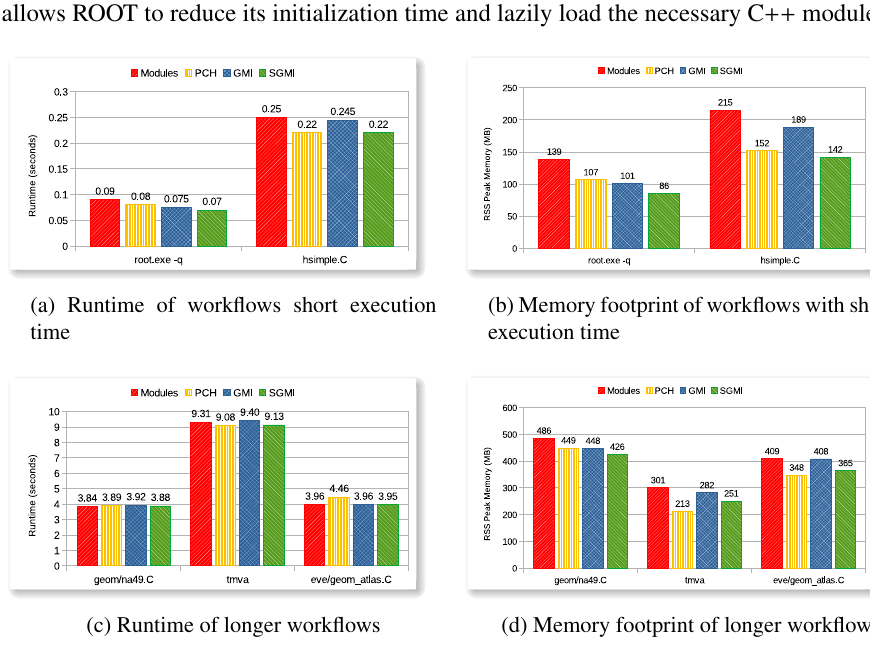
Figure 1: Performance benchmarks in